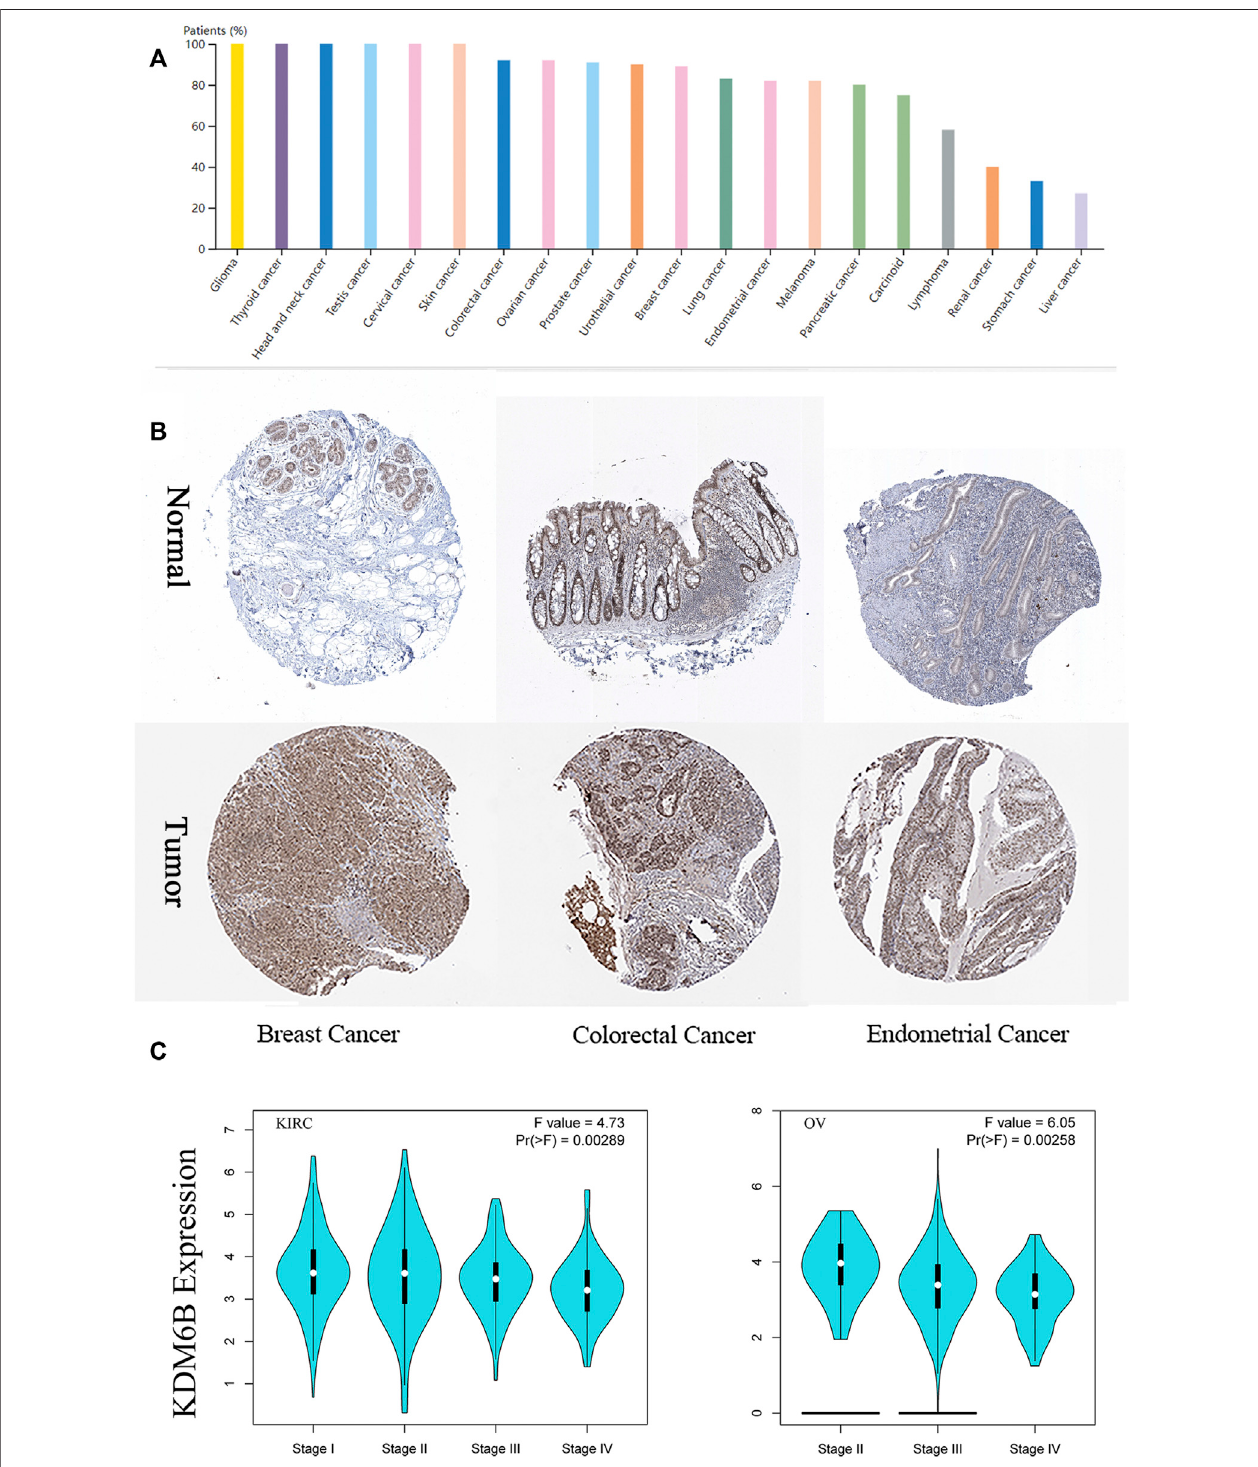
FIGURE 2 | Expression of KDM6B in different tumors and pathological stages. (A) KDM6B protein level across 20 cancer types in Human Protein Atlas (HPA). (B) Representative immunohistochemical staining of KDM6B in HPA. (C) Based on the TCGA data, the KDM6B expression levels were analyzed in the main pathological stages (stage I, II, III, and IV) of KIRC, and OV. log2 (TPM + 1) was applied for log scale.